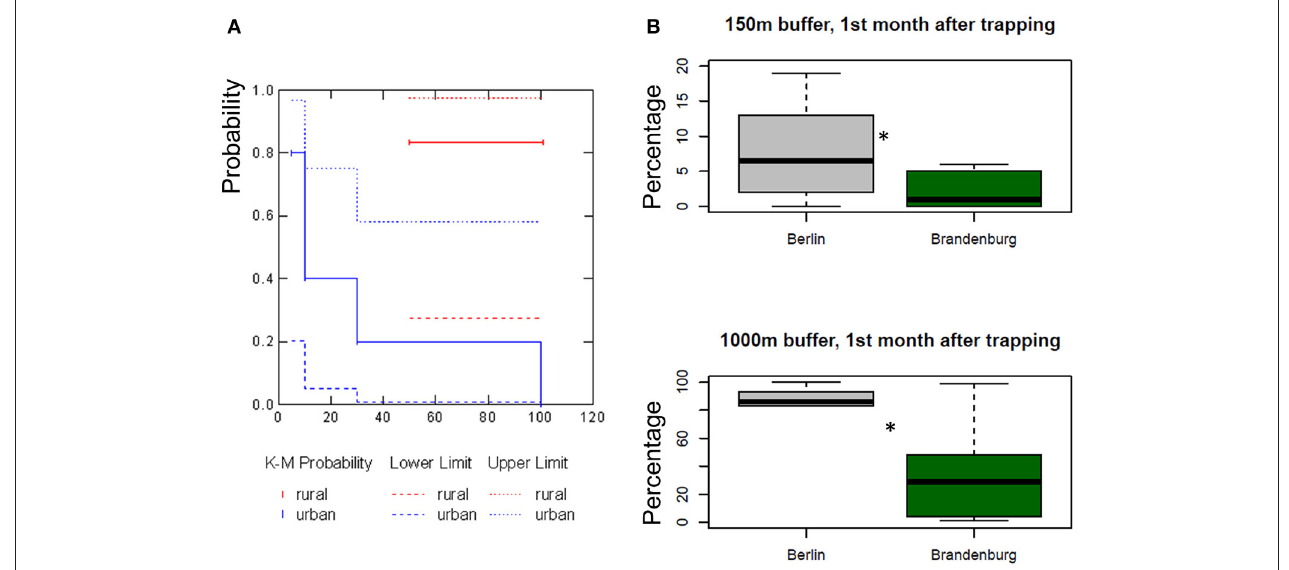
FIGURE 1 | Survival plot for flight distance and reaction to trapping of wild boar in urban and rural areas in Berlin and Brandenburg between 2013 and 2015. (A) Probability for fleeing at a specific distance for urban wild boar ( n = 6) is displayed in blue, upper and lower limits are displayed with a dashed line. The probability for flight distances for wild boar in rural areas ( n = 5) are displayed in red, upper and lower probability limits are again displayed with dashed lines. The plot is the result of a Kaplan–Meier survival analysis. (B) Reaction to trapping was measured by the percentage of locations within a 150m buffer and 1,000m buffer around the trapping location within the first month after trapping. The boxplots show the median as well as 50% quantiles of analysis of the variances (ANOVA, 150 m: p = 0.0368, Df = 17; 1,000 m: p = 0.0128, Df = 17). The *indicates significant differences, indicated by a p -value below